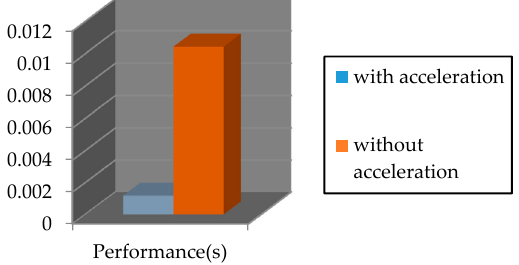
Figure 19. The performance of Coplanar PosIt algorithm.